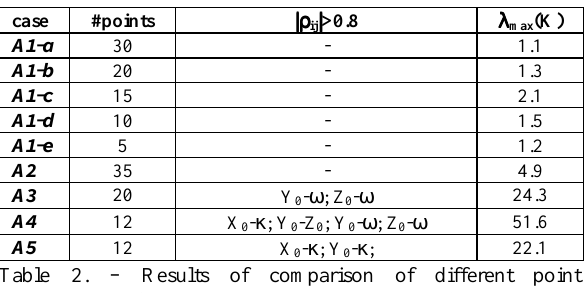
Table 2. – Results of comparison of different point configurations with a criterion matrix from case